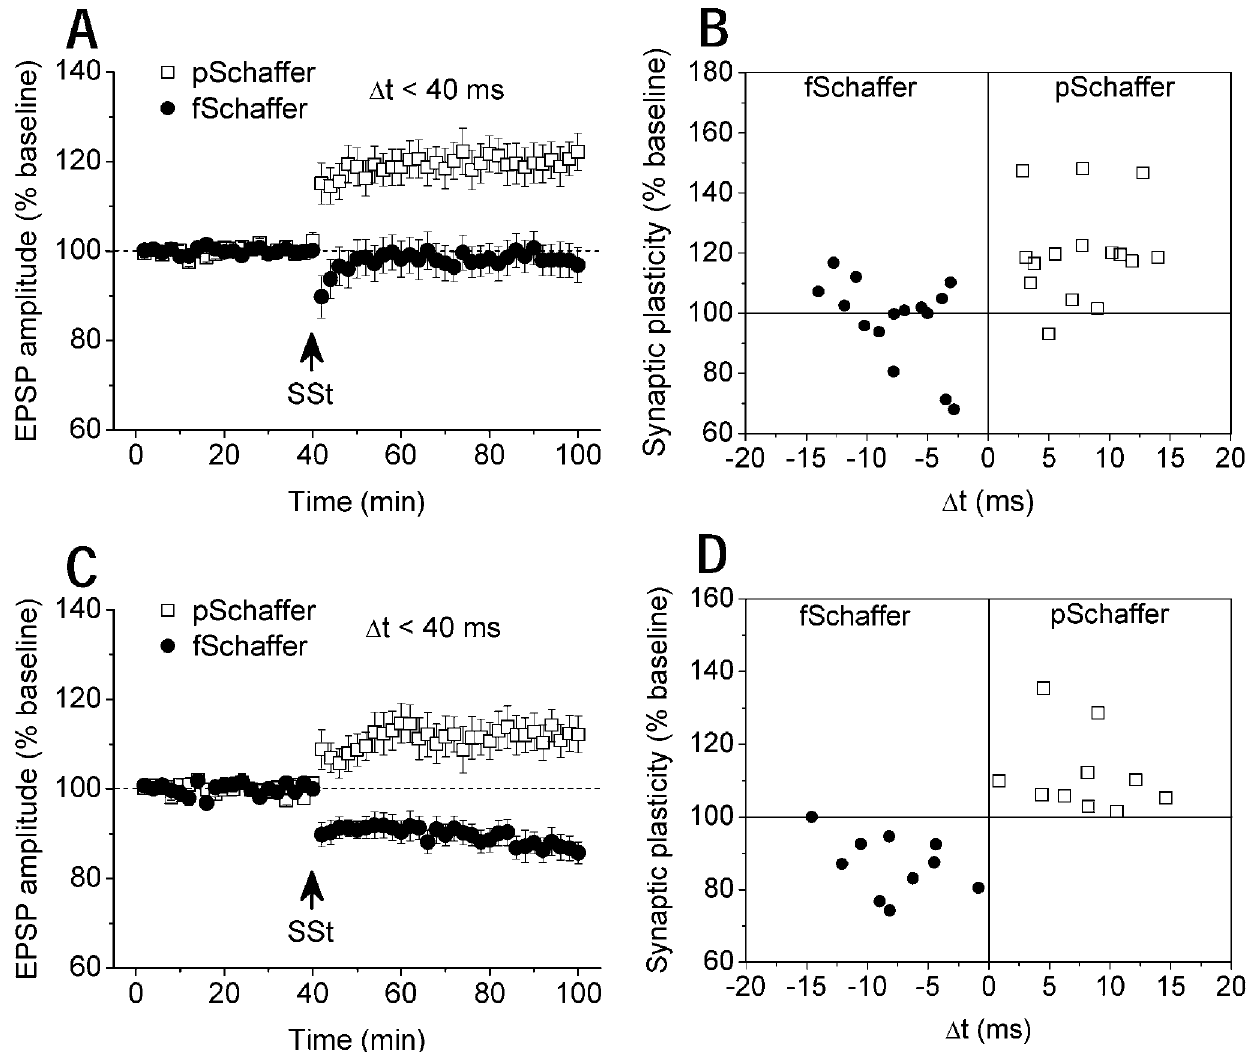
Figure 5. Coincident activity of Schaffer pathways enables synaptic plasticity in CA3-CA1 network. A , In pentobarbital-anesthetized rats, SSt to two Schaffer pathways with one preceding the other ( D t , 40 ms) induced LTP in the pSchaffer without affecting synaptic efficacy in the fSchaffer pathway (n=15; pSchaffer: 120.3 6 4.0%, P , 0.001 vs. baseline; fSchaffer: 97.8 6 3.5%; P=0.273 vs. baseline; P , 0.001 pSchaffer vs. fSchaffer). p=preceding; f=following. B , Individual data confirmed this finding for activity-dependent LTP. C , In urethane-anesthetized rats, SSt to two Schaffer pathways within a 40-ms window consistently induced LTP in the preceding and LTD in the following pathway (n=10; pSchaffer: 112.0 6 3.6%, P=0.007 vs. baseline; fSchaffer: 86.6 6 2.6%; P , 0.001 vs. baseline). D , Individual data confirmed consistent LTP and LTD in the pSchaffer and fSchaffer pathway, respectively.